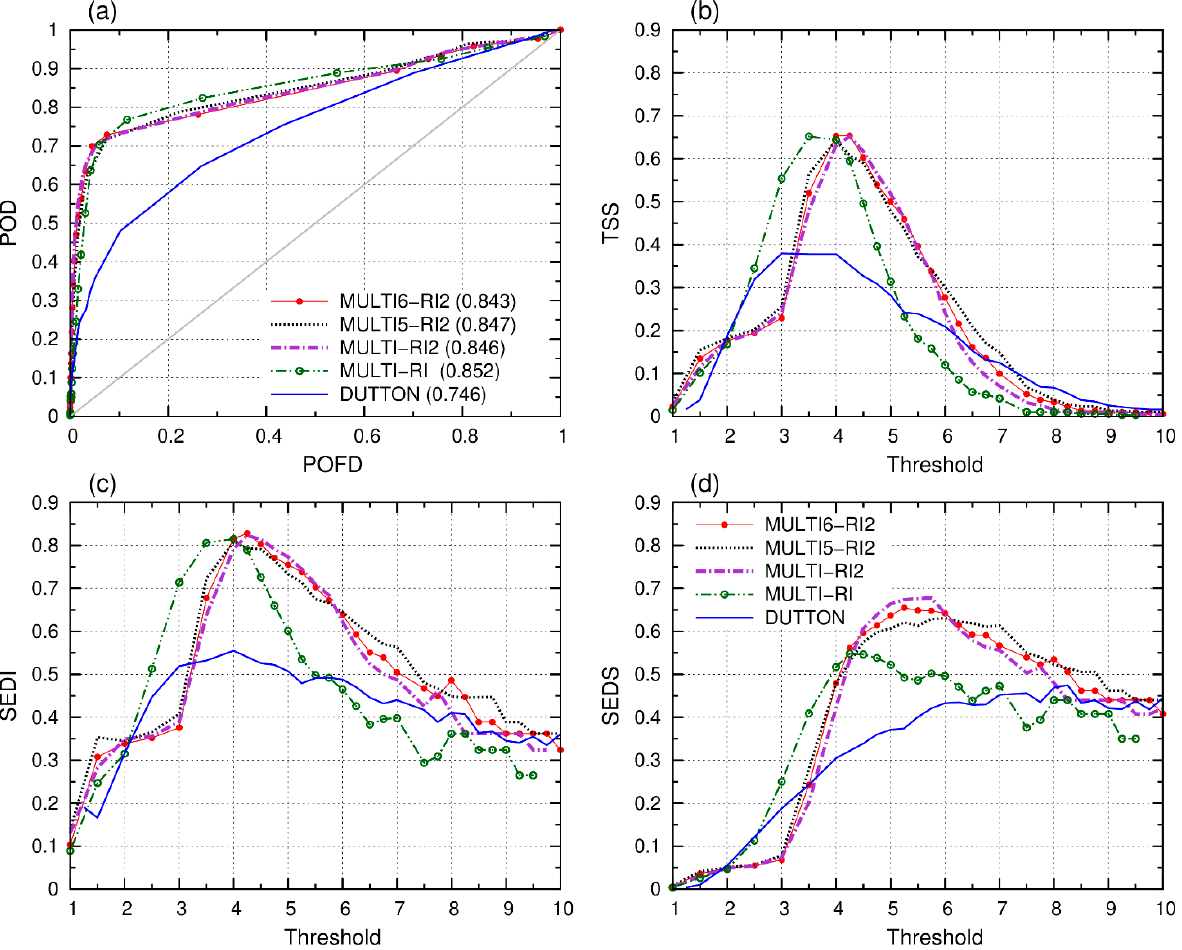
Figure 10. ( a ) ROC curves, ( b ) TSS, ( c ) SEDI, and ( d ) SEDS as function of the threshold. The AUC values are in parentheses in ( a ).